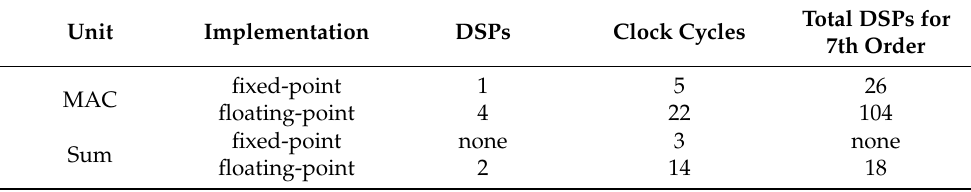
Table 2. Use of DSP resources by the two main computation units of the state-space